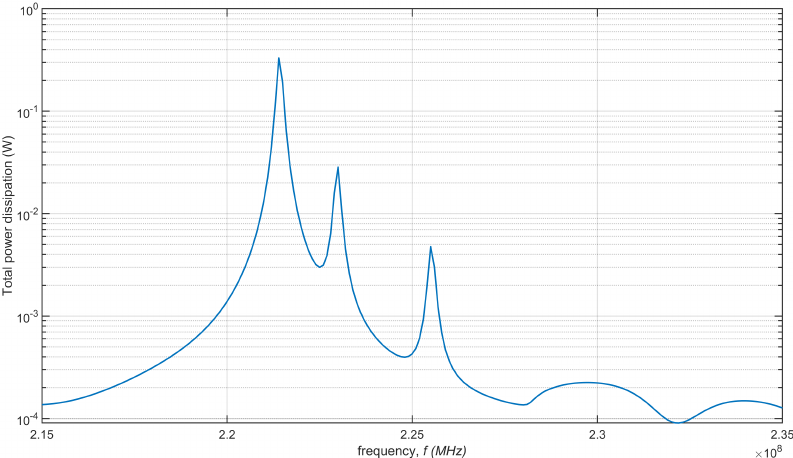
Figure 20. Total power dissipation as a function of